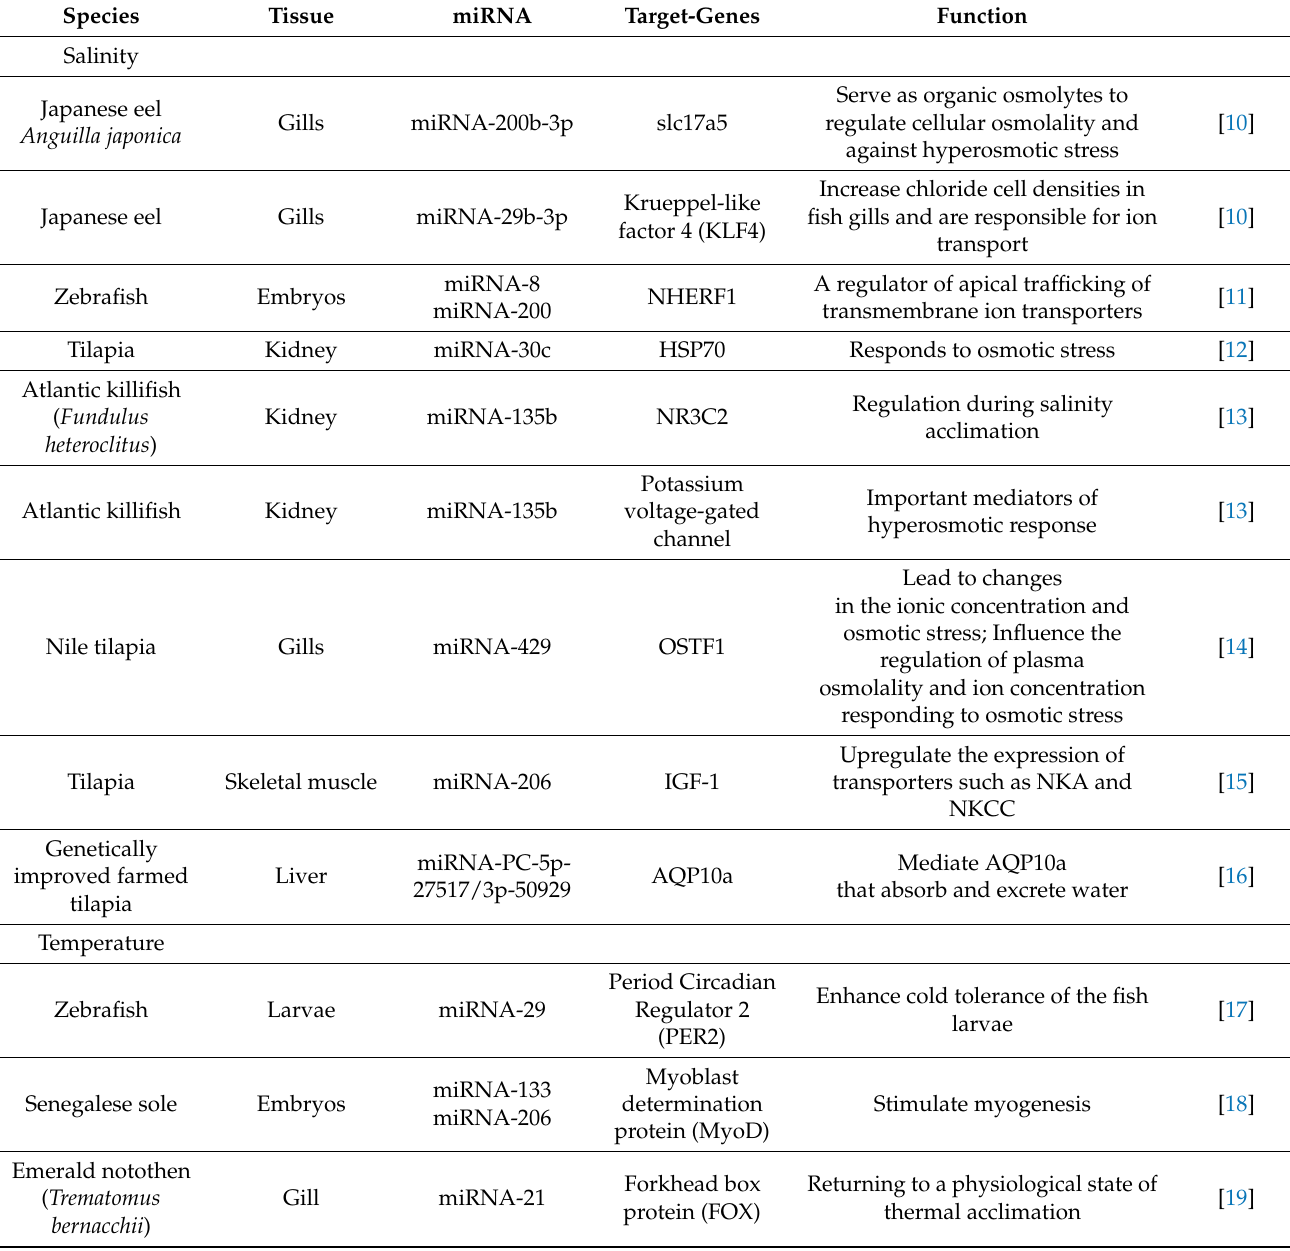
Table 2. Overview of teleost fish studies on selective miRNAs concerning environmental stress including author information, species, tissue, stress type, miRNA list, target genes and function. 17 January